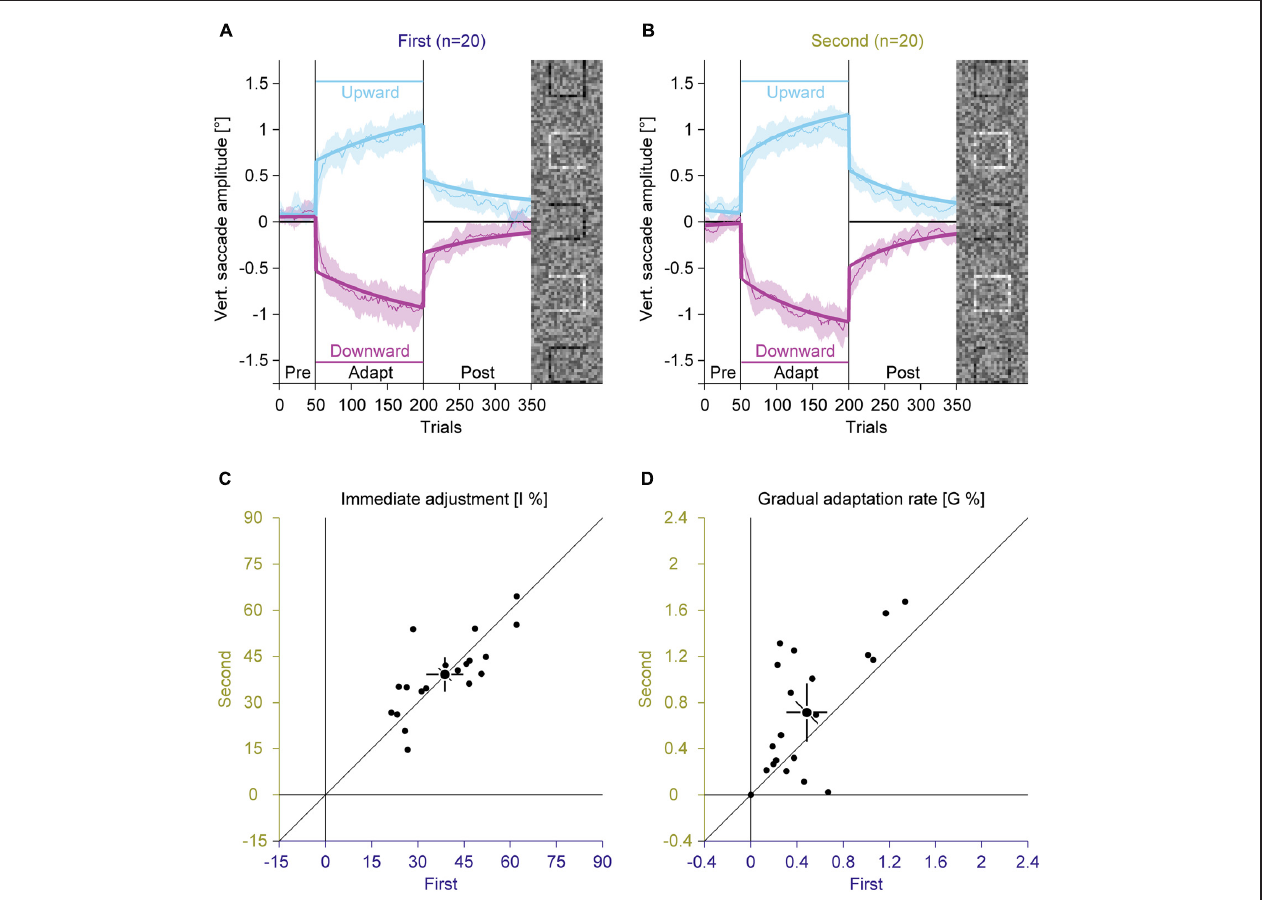
FIGURE 5 | Experiments 1 and 2, saccadic adaptation for the first and the second session. (A) Saccadic adaptation in the first session. (B) Saccadic adaptation in the second session. (C) Immediate adjustment in the two-state model fits. (D) Gradual adaptation rate in the two-state model fits. (A–D) Conventions are the same as in Figure 3